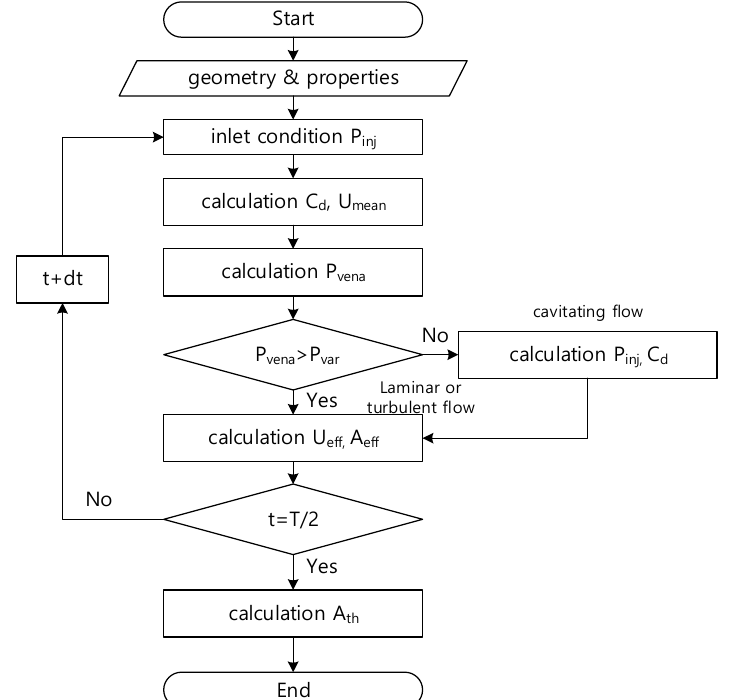
Figure 3. Flow chart of the injector nozzle design.